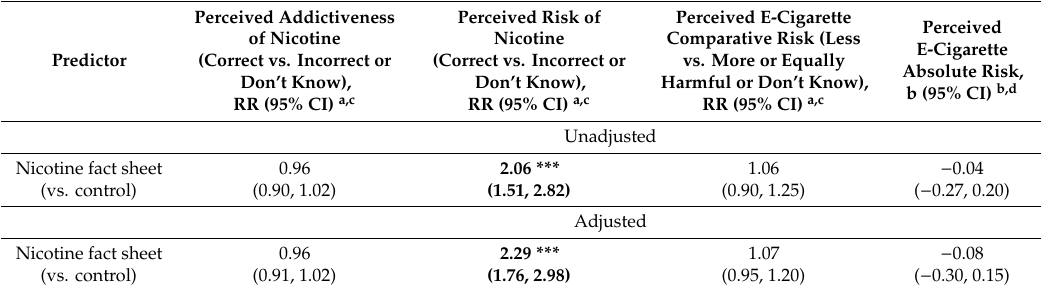
Table 4. E ff ects of a nicotine fact sheet on risk perceptions.